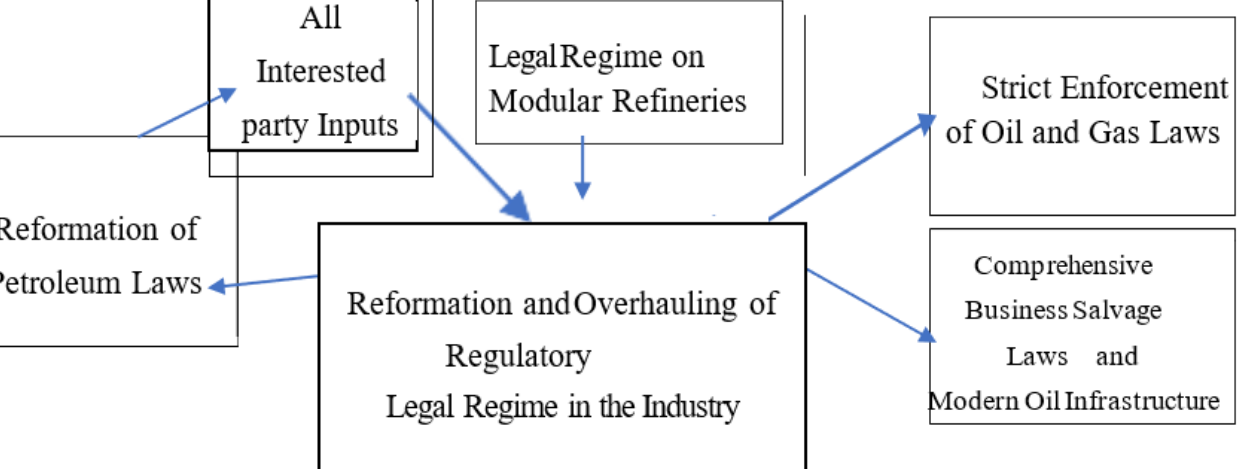
Figure 1. Hybrid Model for the Development of Nigeria’s Crude Oil Refineries. Sources: The Authors Created the Figure